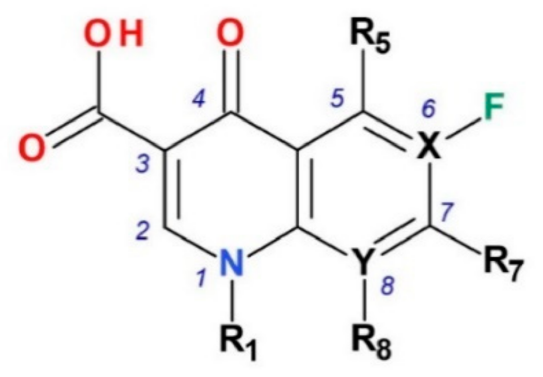
Figure 1. The general chemical structure of FQNs (1,4-quinolones) and numbering (X and Y = C or